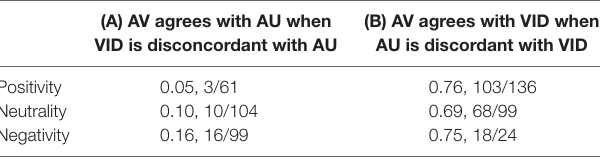
TaBle 3 | For cases where AU and VID judgments of affect were non- concordant, the table presents the proportions where (A) AV judgments agreed with AU judgments or (B) with VID judgments for each of the three affect